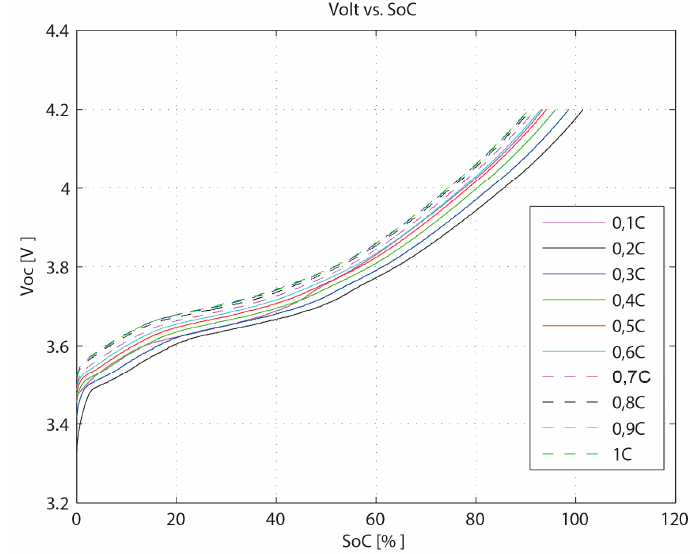
Figure 4. OCV vs. SoC during the charge process at different current values.